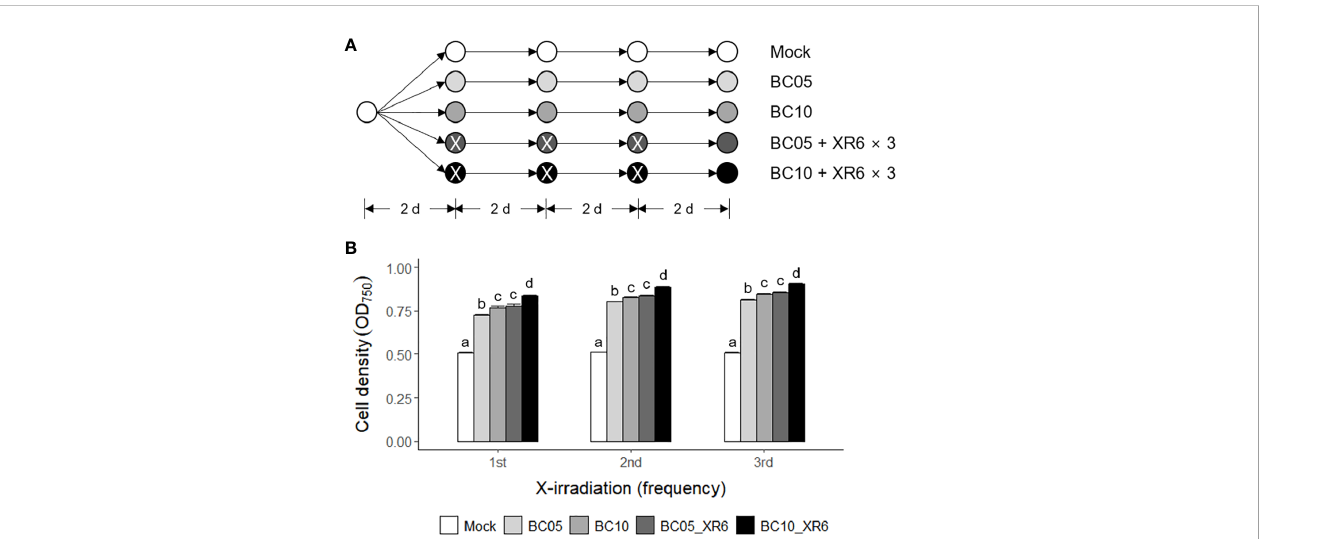
FIGURE 8 Synergistic growth stimulation of C. reinhardtii cells by cultivating in TAP medium containing sodium bicarbonate after repetitive X-irradiation with 6 Gy. BC05, BC10, and XR6 represent 5 and 10 mM NaHCO 3 and X-rays of 6 Gy, respectively. (A) A schematic diagram of repetitive X-irradiation and treatment of NaHCO 3 . The absorbed dose of 6 Gy was repeatedly applied to the X-irradiated cells having an interval of 2 days. The cultivation of the mock was initiated at a cell density of 0.05 OD 750 . The irradiated and/or treated samples were subjected to post-irradiation and/or post-treatment cultivation with the equivalent volume of the mock to cumulate a difference in the growth rate after each X-irradiation and/or treatment of NaHCO 3 . (B) Cell density (OD 750 ) of C. reinhardtii 2 days after single or repetitive X-irradiation. Data represent the mean ± standard error (SE) with n = 6 from two independent experiments. Different letters indicate signi fi cant differences at p < 0.05 (one-way analysis of variance followed by Tukey ’ s honestly signi fi cant difference